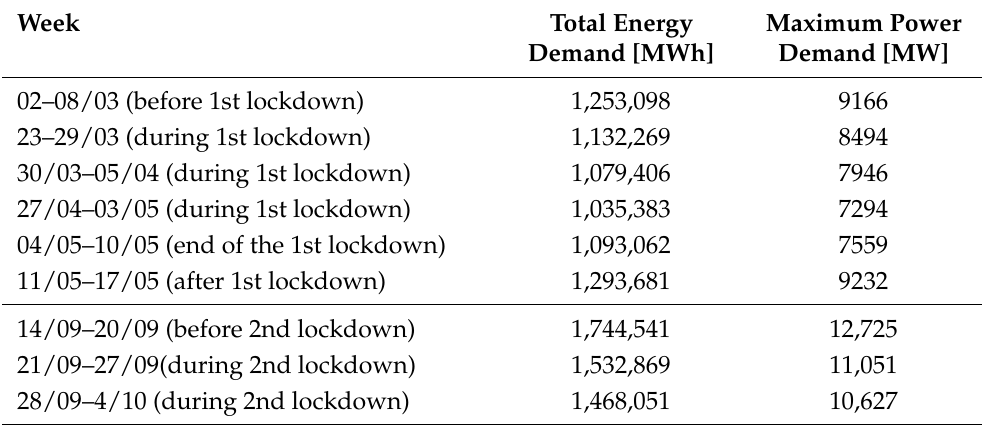
Figure 1. Comparison of the total daily average demand [MW] for 2018, 2019, and 2020 in France and Spain. Table 4. Total energy demand [MWh] and maximum power demand [MW] before/during/after the COVID-19 lockdowns in Israel,